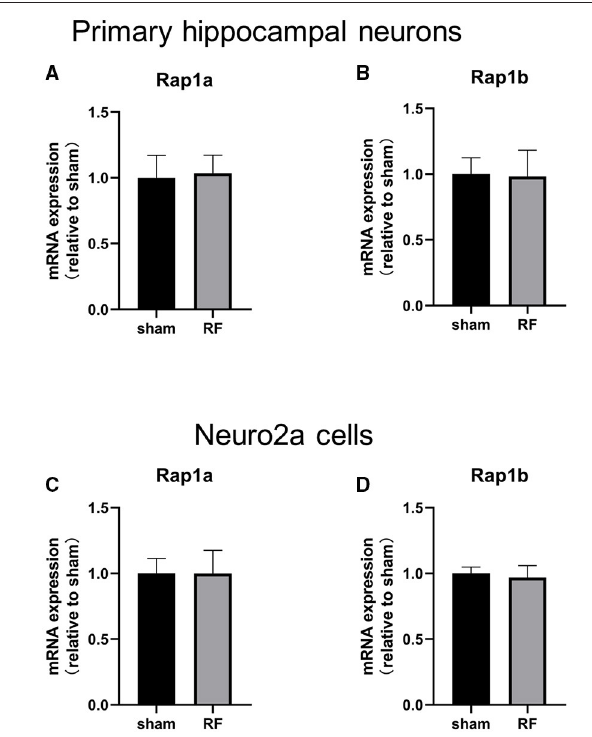
FIGURE 3 | Effects of RF-EMR exposure on the gene expression of Rap1a and Rap1b in neuronal cells. Neuronal cells were exposed to 1,800 MHz RF-EMR for 48h at 4 W/kg. Gene expression was analyzed using real-time quantitative PCR. The Rap1 gene expression in primary hippocampal neurons (A,B) and Neuro2a cells (C,D) after RF-EMR exposure.